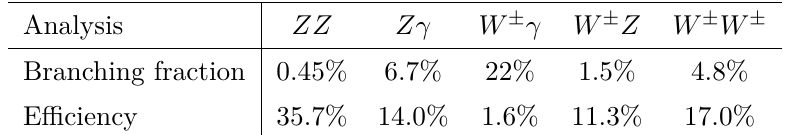
Table 4 . Summary of branching fractions and selection efficiencies for each VBS channel. The efficiencies are relative to the simulated events in which the W and Z bosons decay to electrons or muons.